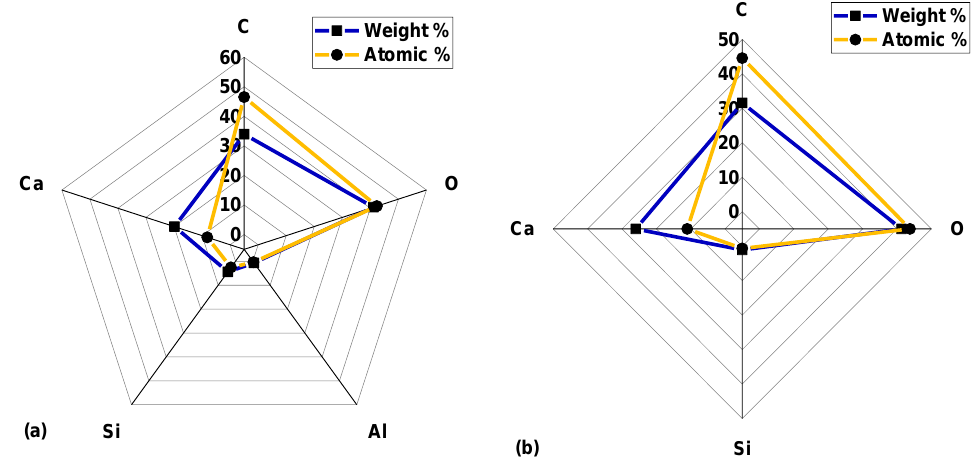
Figure 7. ( a ) Eagle Ford and ( b ) Wolfcamp shales’ detected elements and their associated weights and atomic percentages.